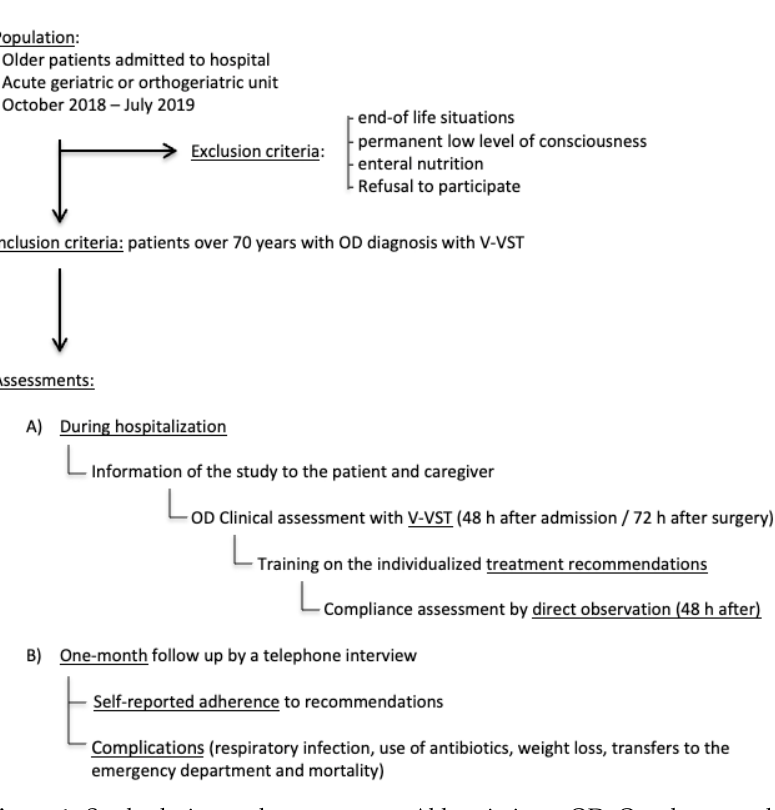
Figure 1. Study design and assessments. Abbreviations: OD: Oropharyngeal Dysphagia, V-VST: Volume-Viscosity Swallow Test, h: hour.